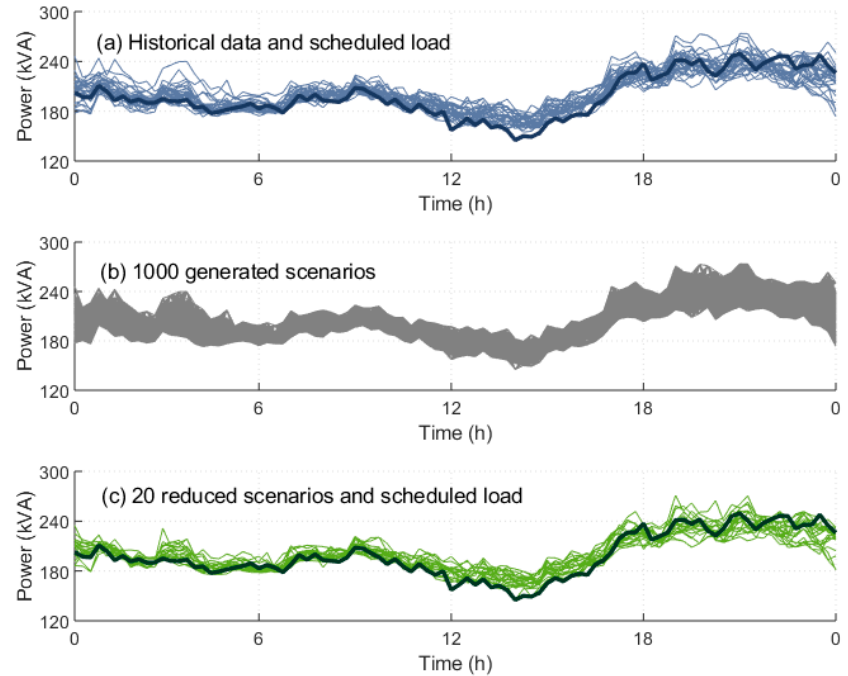
Figure 5. Transformer loading, ( a ) historical values of one month previous and based on scheduled loads for the following day, ( b ) generated scenarios based on Gaussian copula to represent the correlation and ( c ) reduced scenarios and the scheduled load.